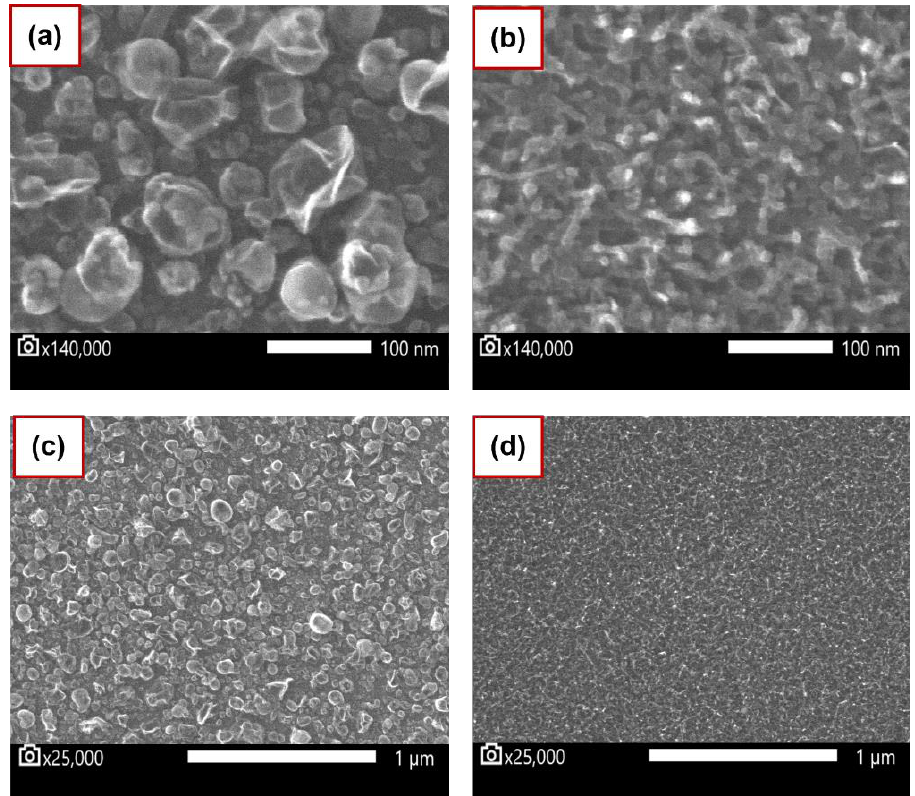
Figure 4. SEM measurements of the graphene growth on SiC substrate: ( a , b ) show the SEM image taken in few layers and multilayers samples at 140,000 × magnification. Similarly, ( c , d ) show the same but at 25,000 ×